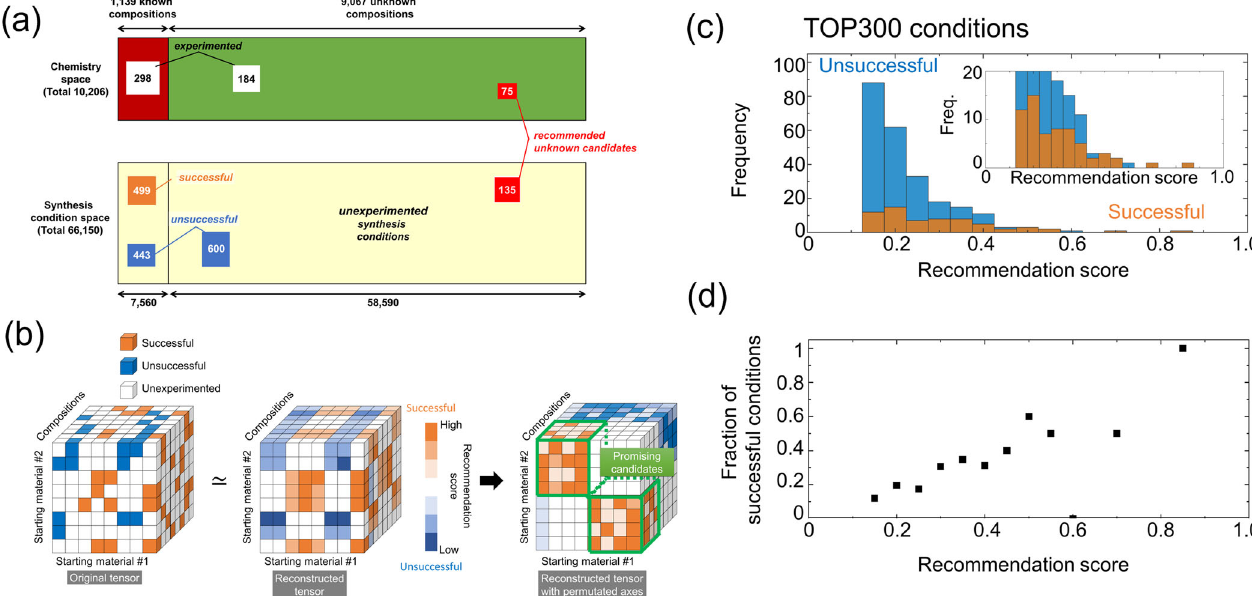
Fig. 7 A synthesis-condition recommender system. a The chemistry space and the synthesis condition space. b A schematic of the Tucker decomposition of the synthesis condition tensor. c Results of additional synthesis experiments for the top 300 synthesis conditions. The number of successful (orange) and unsuccessful (blue) results were shown as a function of the recommendation score. d The fractions of the successful synthesis conditions, i.e., success rate, for each bin of the recommendation score in c . Adopted from ref. 32 with small modi fi